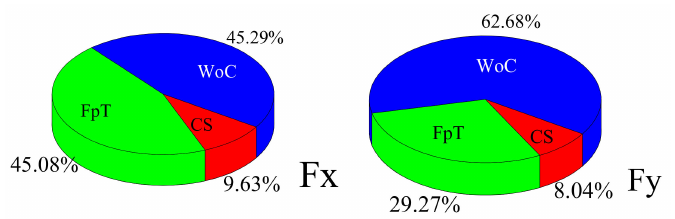
Figure 17. Relative sensitivity of milling parameters to cutting